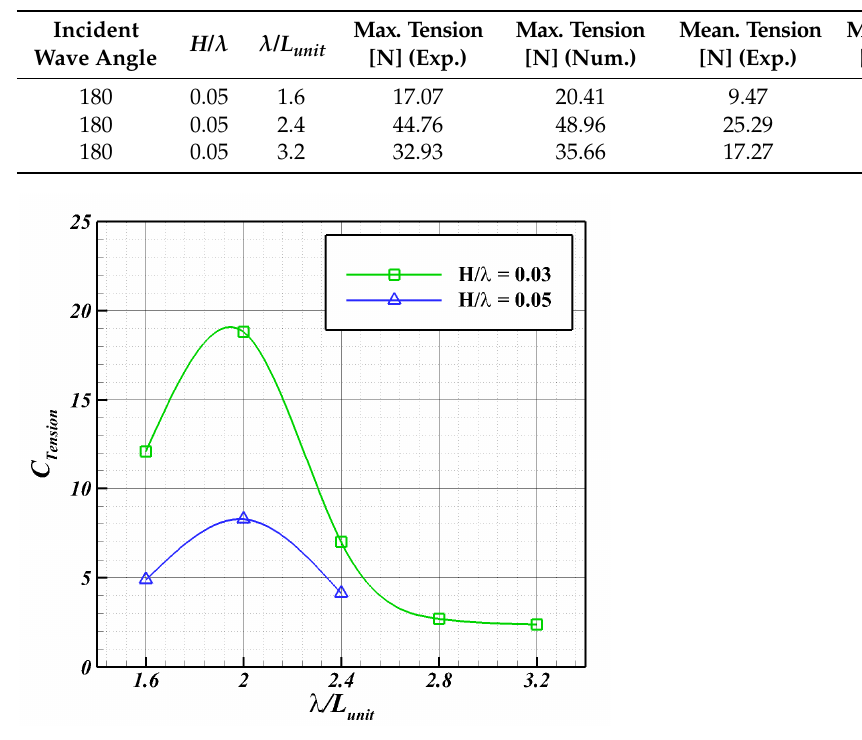
Figure 24. Comparison of tension coefficient according to wave steepness.